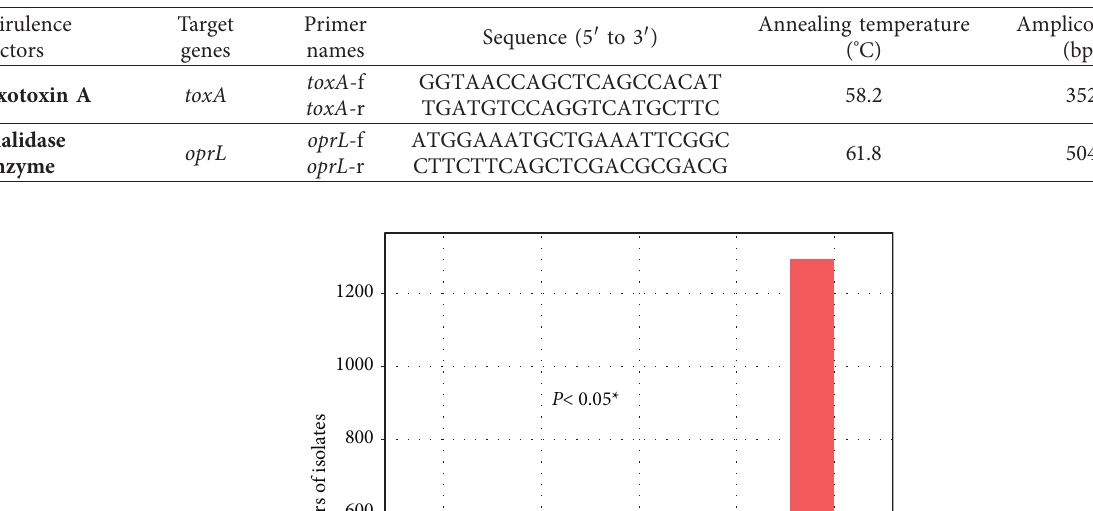
Table 1: Nucleotide sequence of primers and condition used to amplify species-specific virulence genes in P . aeruginosa by PCR.